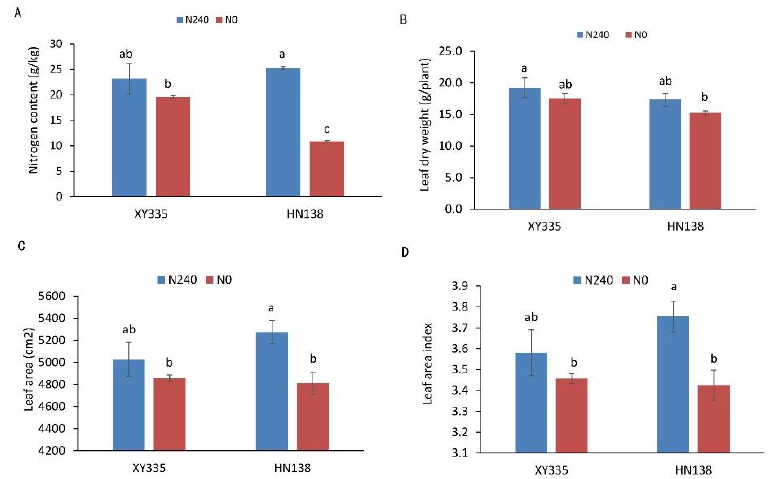
Figure 1. Phenotypic and physiological analysis of two maize hybrids under two nitrogen treatments. ( A ) Leaf nitrogen concentration, ( B ) leaf dry weight, ( C ) leaf area, ( D ) leaf area index. Different letters in the figure indicate significant differences ( p < 0.05) between hybrids or treatments.